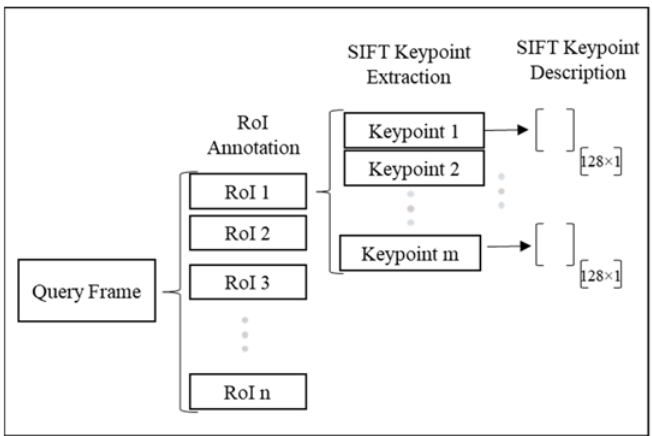
Figure 3. Feature extraction for ground truth and the rest of the video.